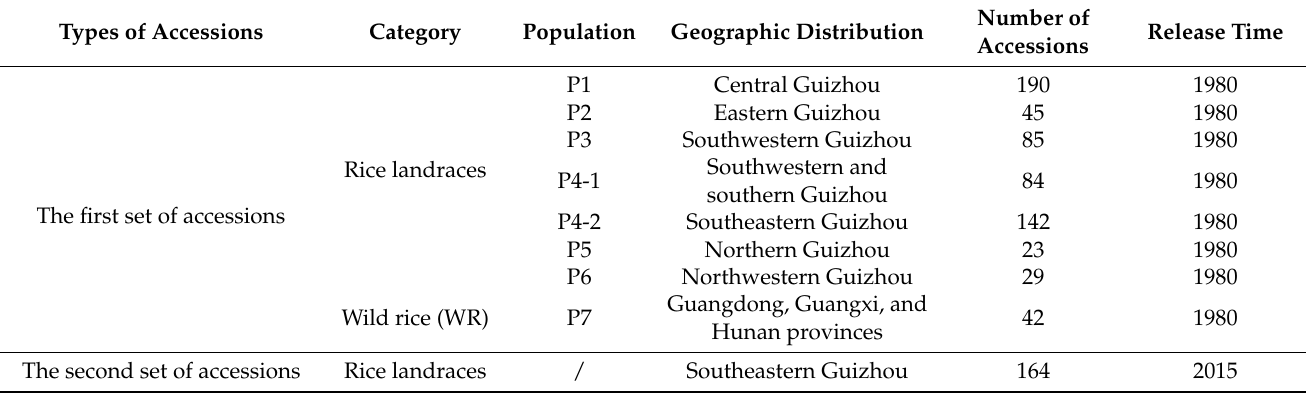
Table 1. Basic information of rice landrace accessions used in this